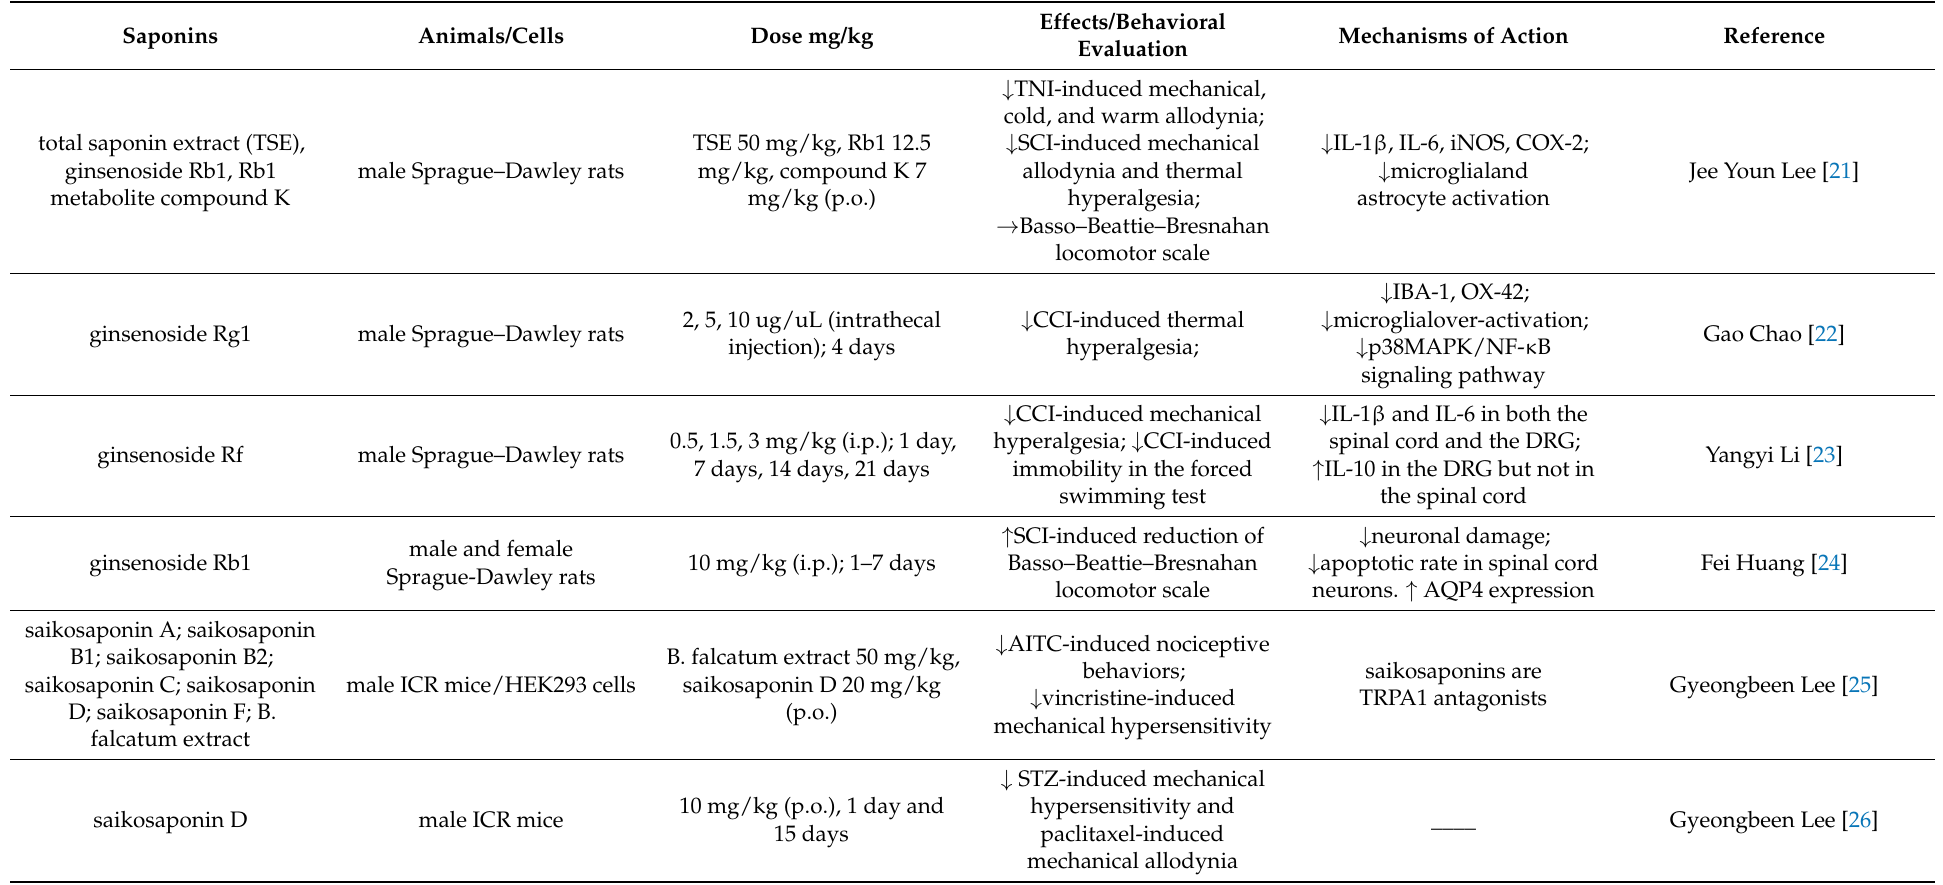
Table 1. Effects of saikosaponins on neuropathic